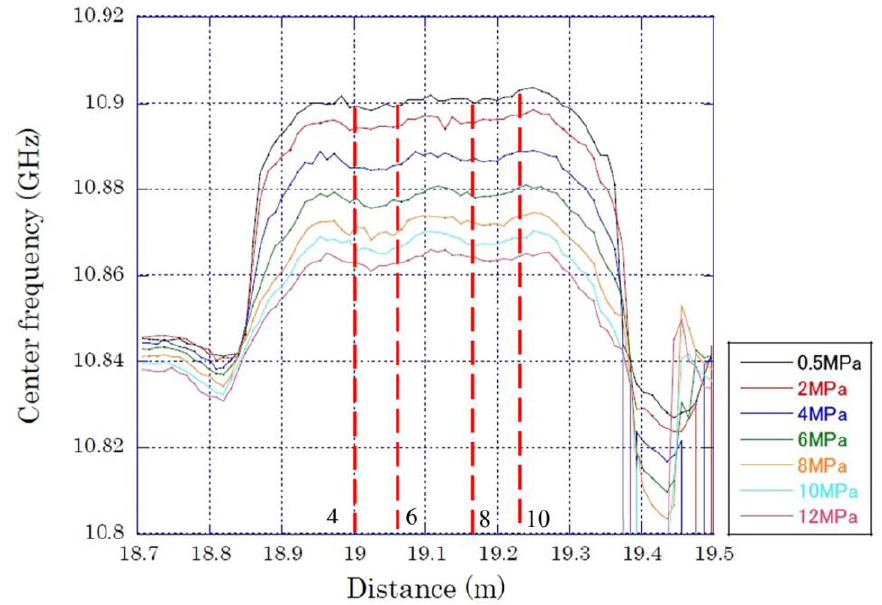
Figure 7. Berea core Brillouin frequency measurements with increasing confining pressures. The locations of a few selected monitoring points are marked.